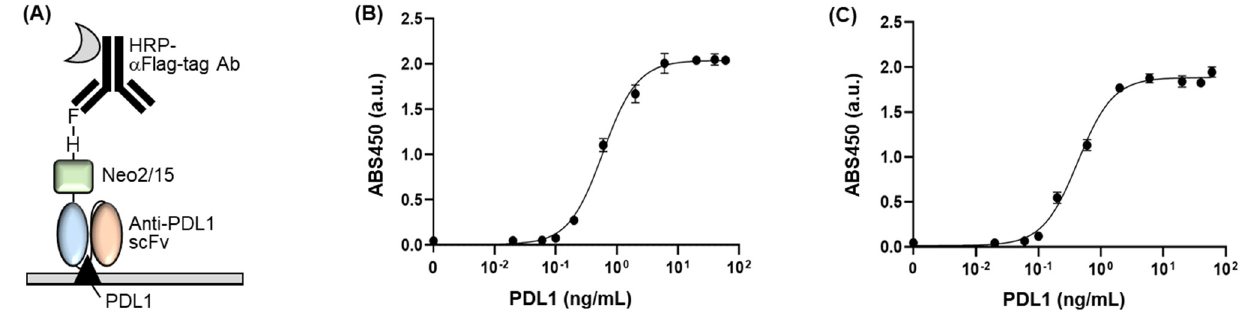
Figure 4. ( A ) Schematic representation of the indirect ELISA for confirming the dose-dependent PD-L1-binding efficiency of the fusion protein. ( B ) ELISA signal of Flag-tag-purified fusion protein with various concentrations of PD-L1. ( C ) ELISA signal of His-tag-purified fusion protein with various concentrations of PD-L1. Error bars represent ±1 SD (n = 3).